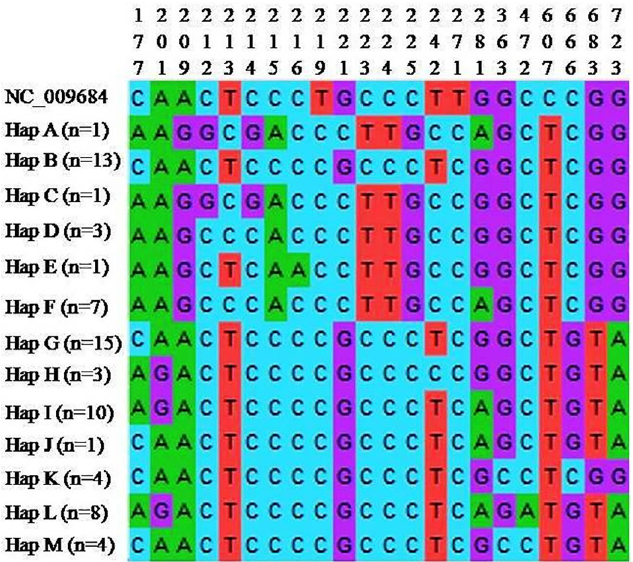
Fig 3. Sequence alignment of different haplotypes of ALD with mallard reference sequence (NC_009684). Only variable sites are shown. The sequence positions of every variable sites are indicated above. Multiple sequence alignment was done by ClustalW programme implemented in